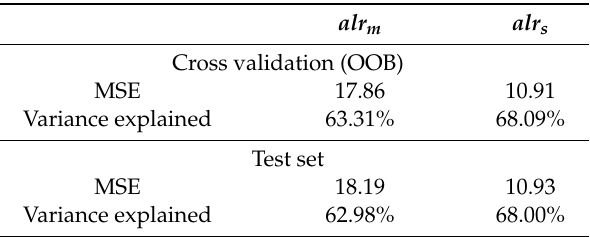
Table 2. Model performance measured using out-of-the-box cross-validation and independent test data set.